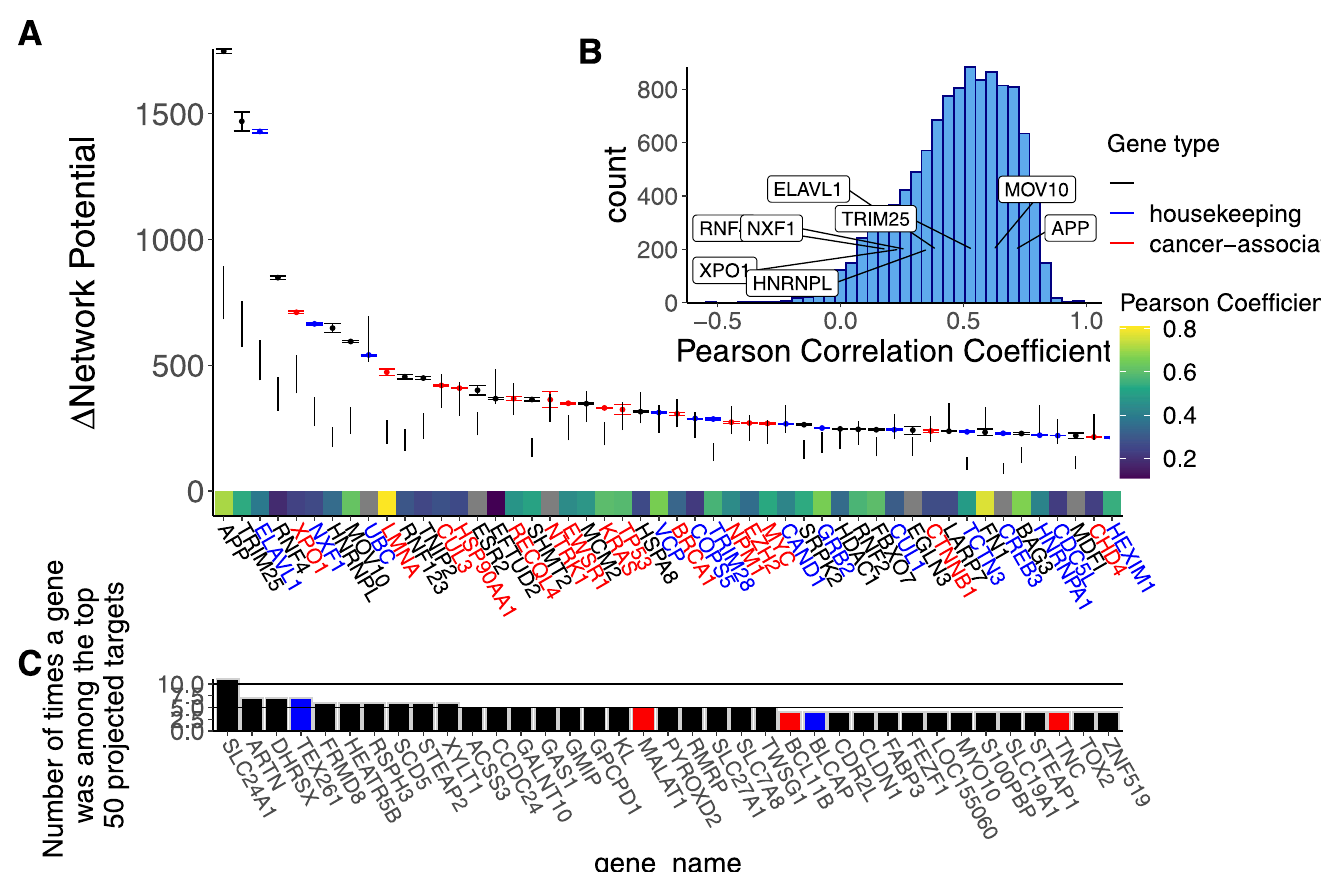
Fig 4. TRIM25, APP, ELAVL1, AND RNF4, and XPO1 are the top protein targets ranked by predicted disruption following in silico repression. Panel A : Box and whisker plot describing the change in network potential following in silico repression for each of the top 50 proteins. 99.99% confidence interval from the permutation test are displayed alongside the box and whisker plots. It is notable that EWSR1, the kinase associated with Ewing sarcoma development, is considered highly influential in the cell signaling network by this method, even in comparison to the computed null distribution. Genes that have previously been causally implicated in cancer according to the Cosmic database are highlighted in red [41]. Essential housekeeping genes (excluding those that are causally implicated in cancer) are highlighted in blue. The heat-map on the x-axis corresponds to the protein-mRNA correlation of each gene in the Cancer Cell Line Encyclopedia [34]. Panel B : Histogram depicting the distribution of Pearson correlation between mRNA expression and protein expression from the Cancer Cell Line Encyclopedia for all nodes included in our final Ewing sarcoma cell signaling networks. Proteins that were ranked particularly highly in panel A were labeled in panel B. Pancel C : Bar chart describing the most frequently observed genes among the top projected targets for the 15 patient tumor samples we analyzed. There was very little overlap in top projected targets between the cell line and patient data, reflecting the transcriptional heterogeneity present in Ewing